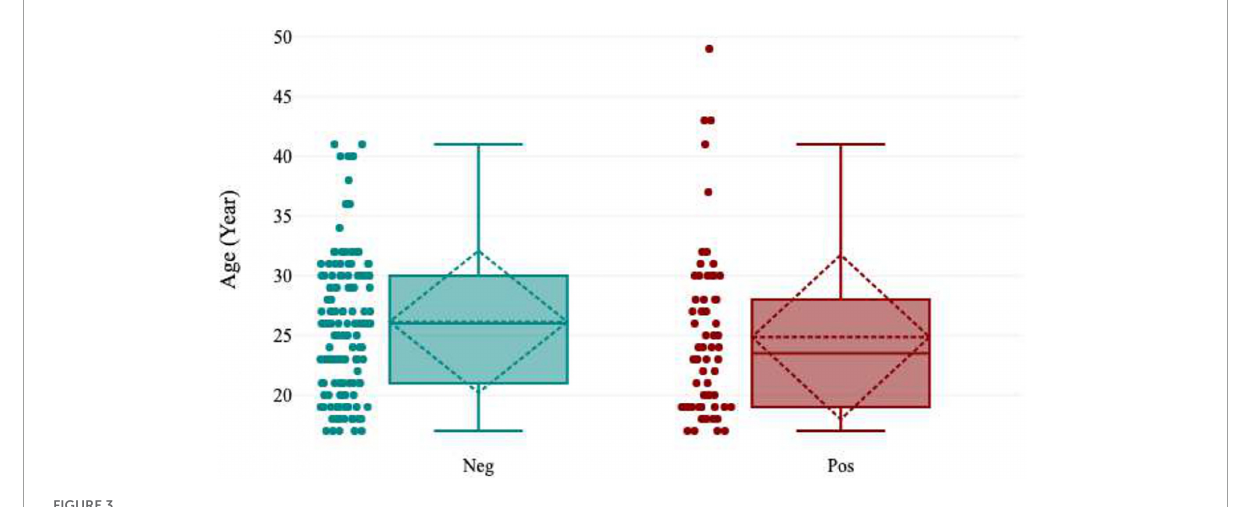
FIGURE3 Boxplot showing the age-specific seropositivity of HEV in pregnant